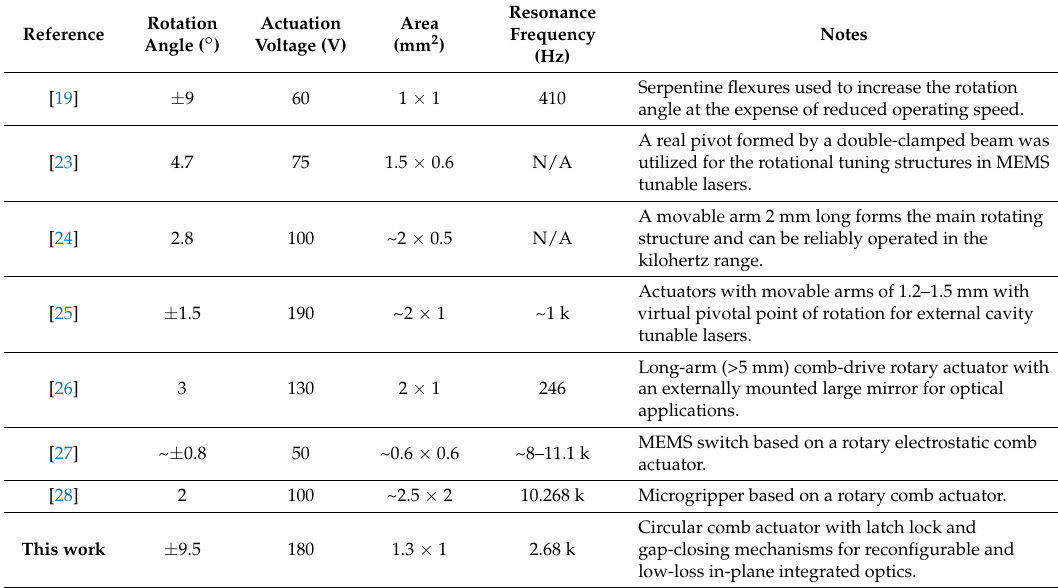
Table 1. Comparison of MEMS Rotational Electrostatic